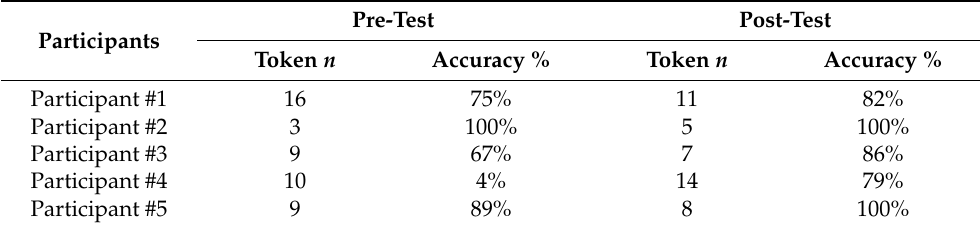
Table 6. Results of the usage of the particle ma in the open-ended questions.